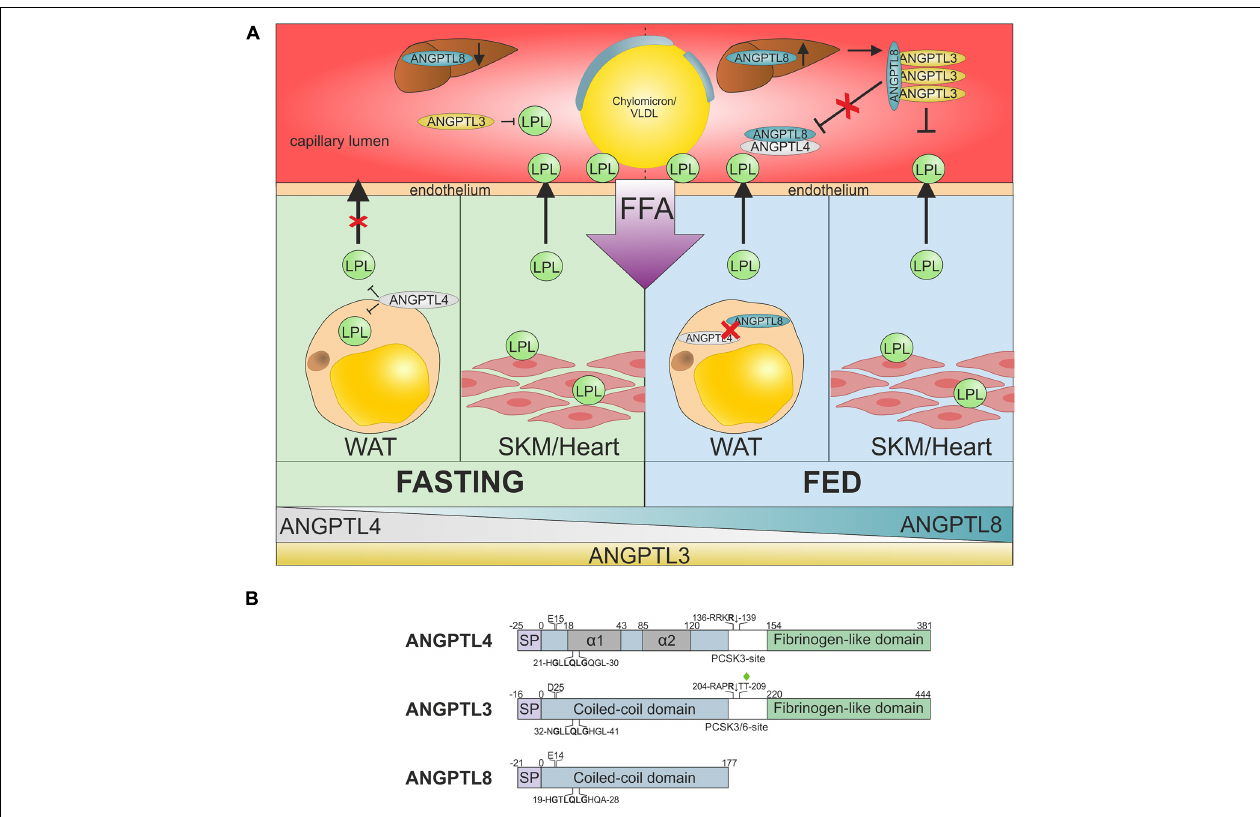
FIGURE 4 | ANGPTL-3, − 4, and − 8 regulate nutrition-dependent TRL processing across tissues. (A) Suppression of LPL activity in oxidative and storage tissues by ANGPTL inhibition in the fed and fasted state. During fasting ( green ) or exercise, TRLs need to be directed away from storage in WAT toward oxidative tissues, such as heart and skeletal muscles (SKM). This is accomplished by (i) upregulation of ANGPTL4 in WAT, which suppresses LPL secretion and inactivates LPL in the sub-endothelial space, and (ii) downregulation of hepatic ANGPTL8 expression, which greatly reduces the potency of ANGPTL3-mediated LPL inhibition